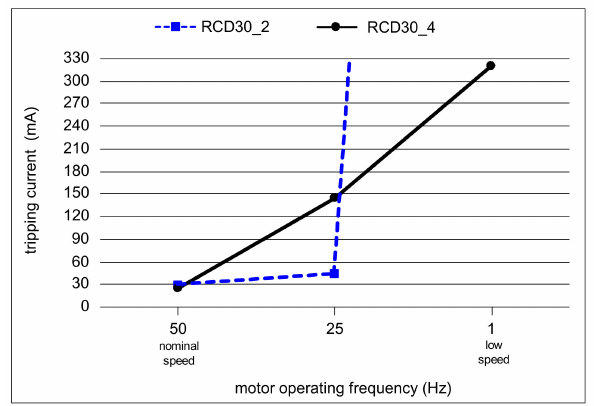
Figure 14. Tripping current of two RCDs ( I ∆ n = 30 mA) for testing currents comprising many harmonics as in a variable-speed drive circuit.